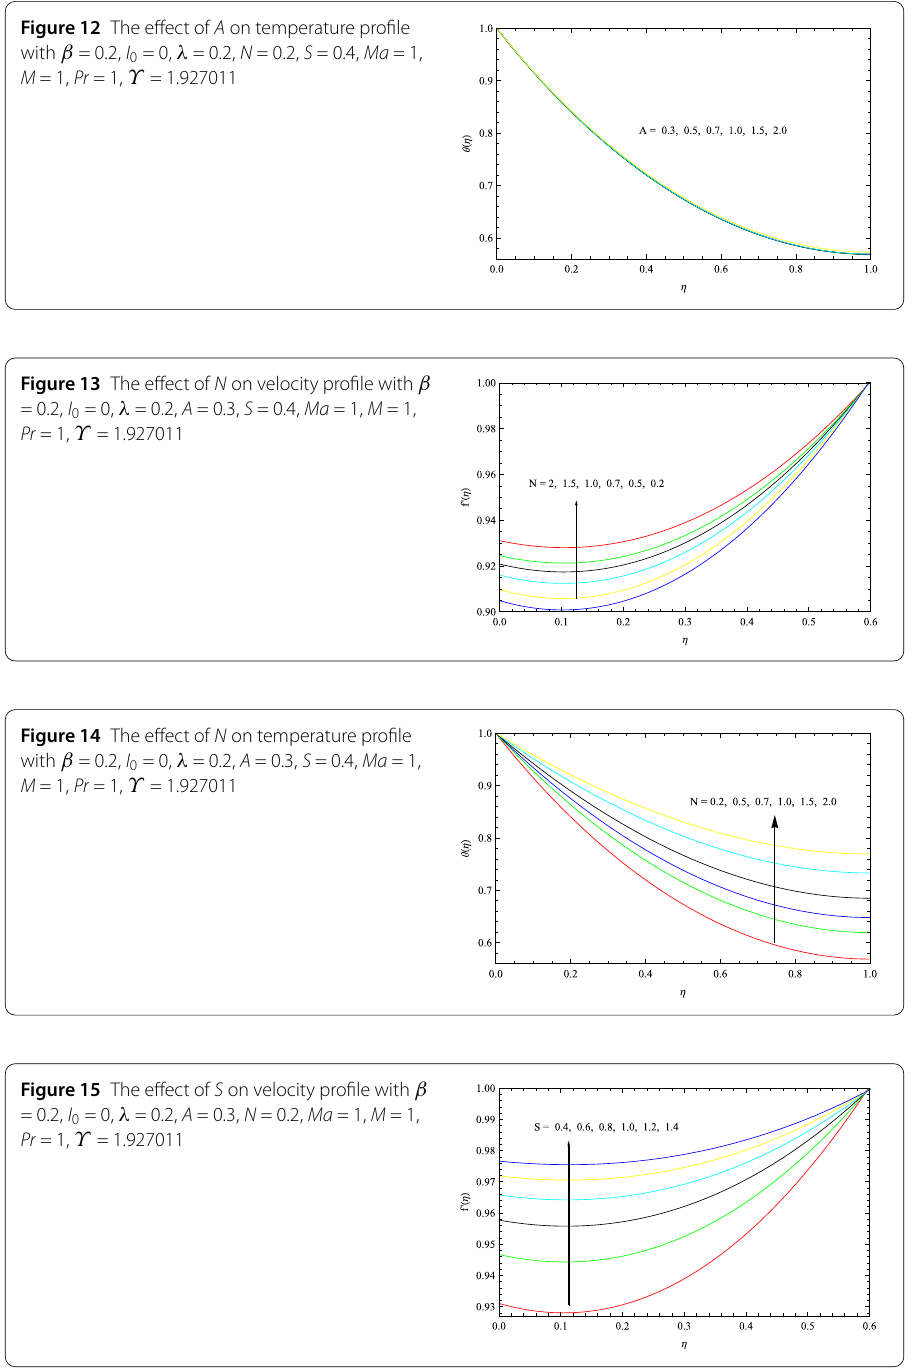
Figure 12 The effect of A on temperature profile with β = 0.2, I 0 = 0, λ = 0.2, N = 0.2, S = 0.4, Ma = 1, M = 1, Pr = 1, Υ = 1.927011